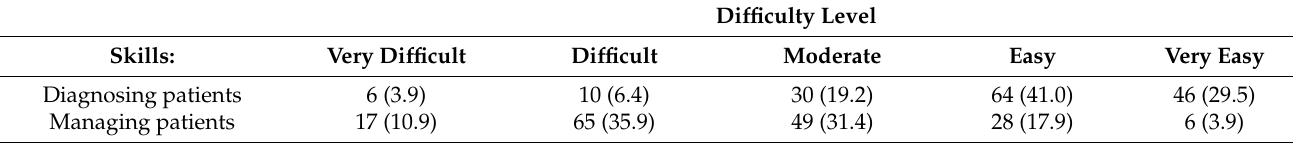
Table 2. Students’ feedback on their current periodontal assessment